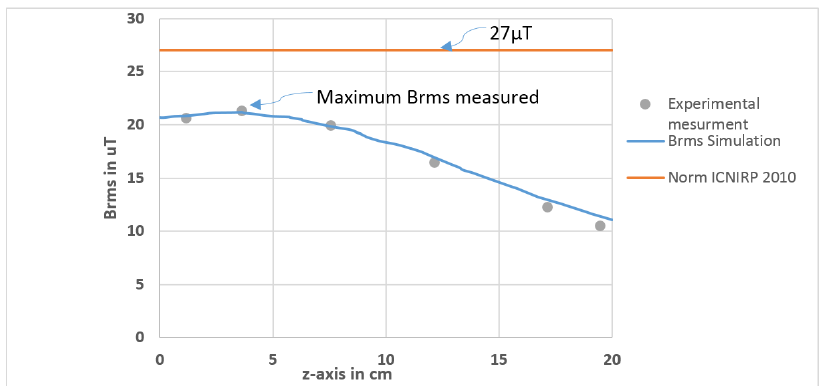
Figure 4. ( a ) Magnetic field streamline and its flux density in tesla (T) of 160 W wireless charging system at 30 kHz; ( b , c ) simulation and experimental models to measure the B rms of the magnetic flux density.